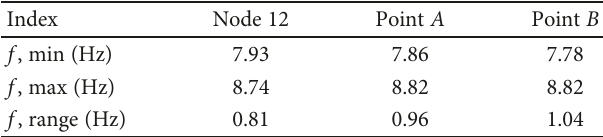
Figure 65: D5, maximum frequency, excitation far from the damage. Table 7: D2, excitation near the damage, localization indexes.